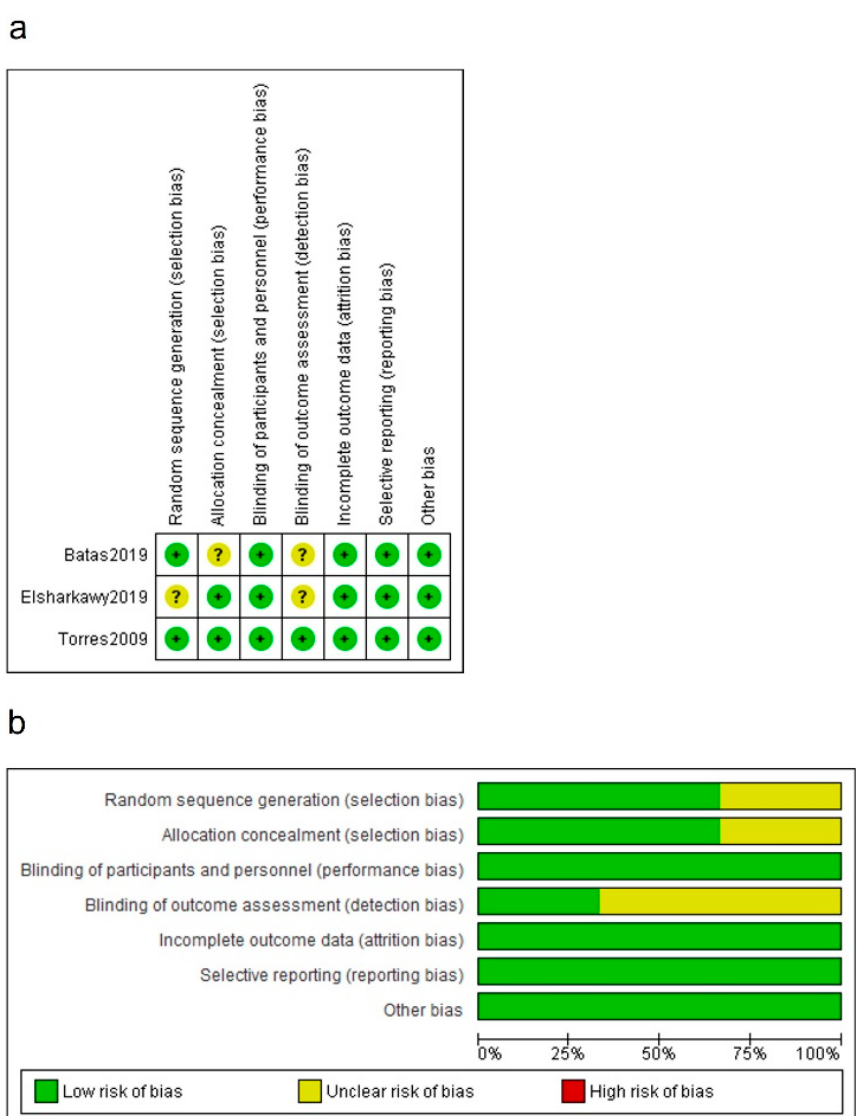
Figure 2. Quality assessment of the included RCTs. ( a ) Risk of bias summary, review of authors’ judgments about each risk-of-bias item for each included study. (+): low risk of bias. (?): unclear risk of bias. ( b ) Risk-of-bias graph, review of authors’ judgments about each risk-of-bias item, presented as percentages across all included studies